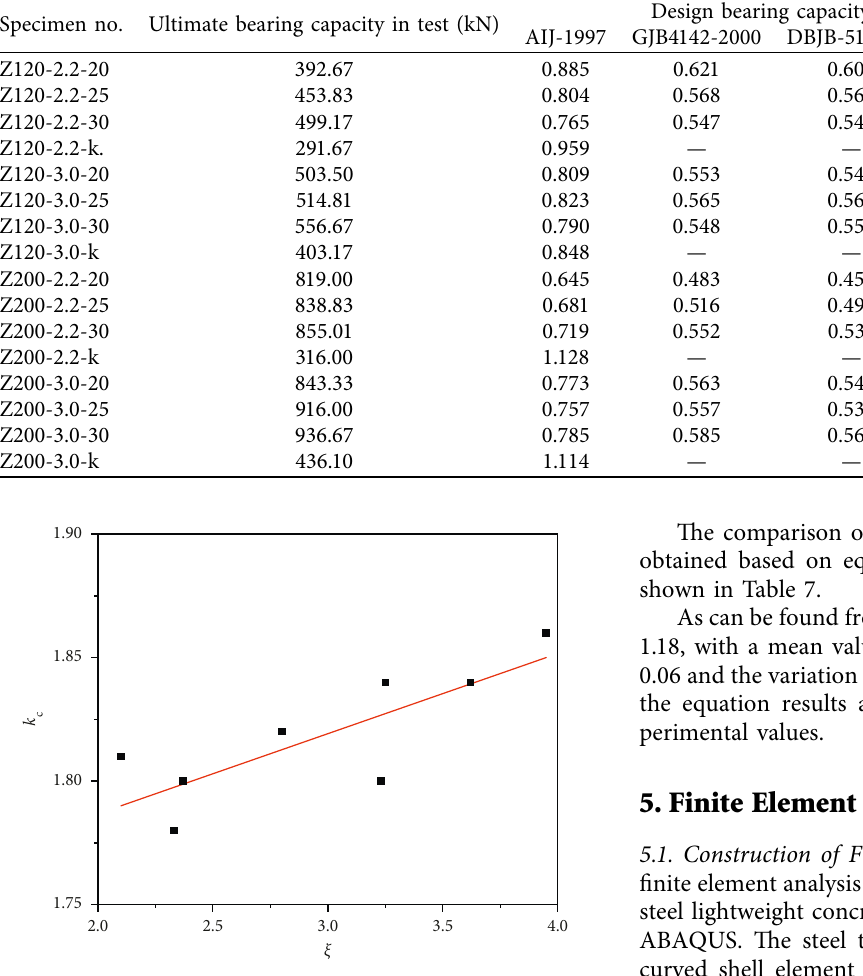
Figure 13: Regression curve of k Table 7: Comparison of calculated and test